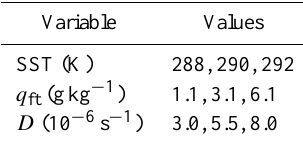
Table 5. Values of environmental